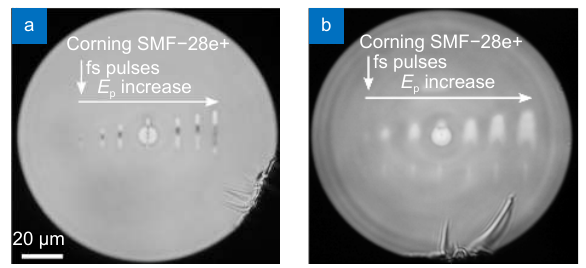
Fig. 4 | Refractive index change induced by fs laser pulses in the cross section of a single-mode fiber in the case of a Gaussian beam ( a ) and an astigmatic Gaussian beam ( b ) for different pulse